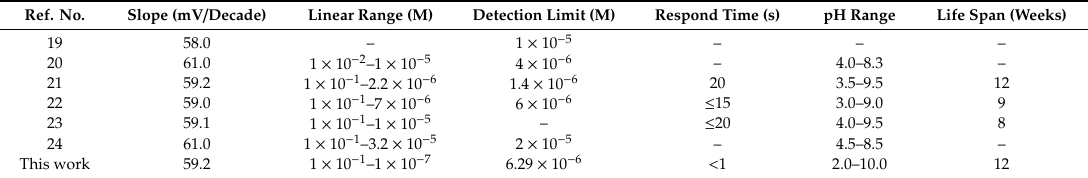
Table 4. Performance comparison of bromide electrode between previous works and current work. Ref.